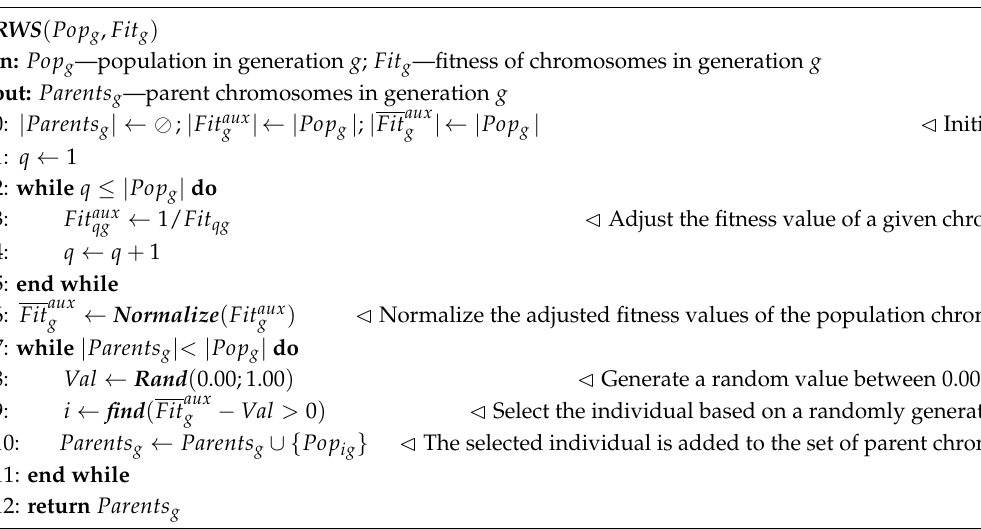
Algorithm 2: Roulette Wheel Selection (RWS). RWS ( Pop g , Fit g